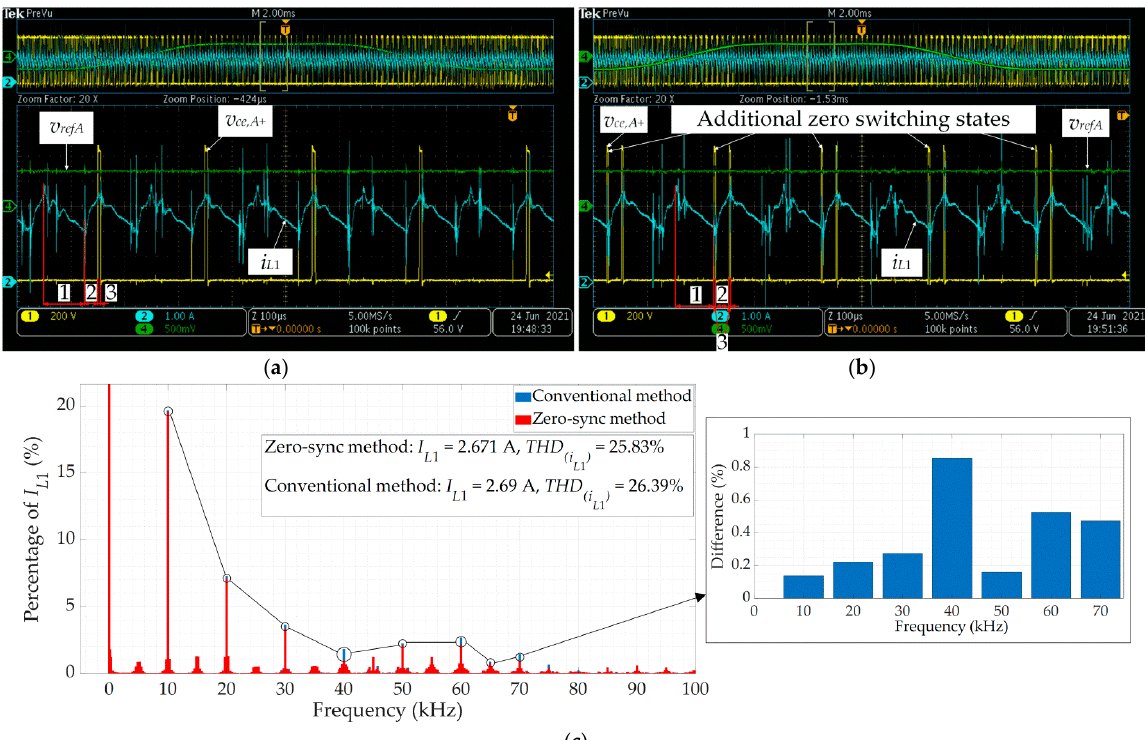
Figure 10. Waveforms of the reference voltage of phase A, collector-emitter voltage of the upper transistor in the phase A, and qZSI input current in case of implementing the zero-sync method ( a ) and the conventional method ( b ), the harmonic spectrum of the qZSI input current waveform ( c ).